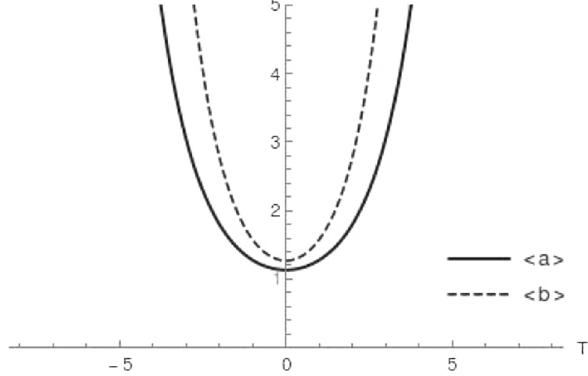
followed by expansion avoiding any singularity indicating a bouncing universe. Similar results were obtained in quanti- zation of anisotropic models in absence of fluid in the past [39]. This result is obtained with quite reasonable boundary conditions, Ψ → 0 for infinite values of its arguments, ¯ u and ¯ v . For a discussion, we refer to the work of Vilenkin and Yamada [43] and Tuccil and Lehners